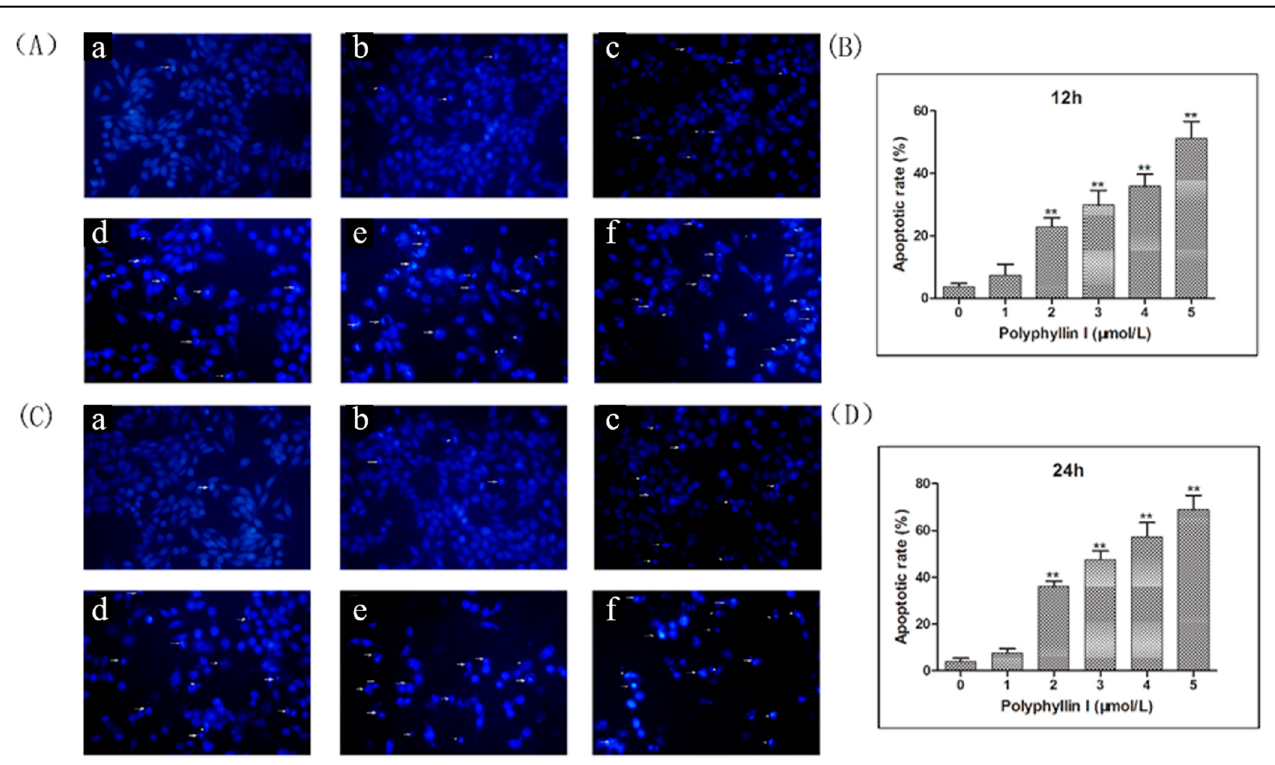
Figure 2. The effect of PPI on the karyomorphology of SW480 cells (400×). ( A , C ): the SW480 cells were stained with DAPI after treatment for 12 and 24 h, respectively (note: a negative control group; b: treated with 1 μ mol/L PPI; c: treated with 2 μ mol/L PPI; d: treated with 3 μ mol/L PPI; e: treated with 4 μ mol/L PPI; f: treated with 5 μ mol/L PPI); ( B , D ): the quantitative analysis of the apoptotic cell number. n = 3, the data are presented as means ± SEM. ** p < 0.01. Arrows indicate the apoptotic cells.